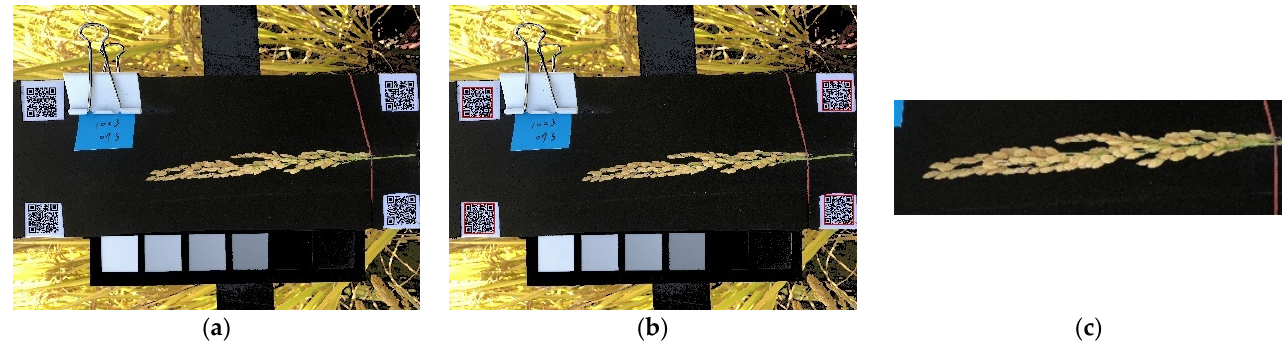
Figure 8. ROI cropped display. Corrected image ( a ), QR code detection ( b ), and ROI area ( c ).